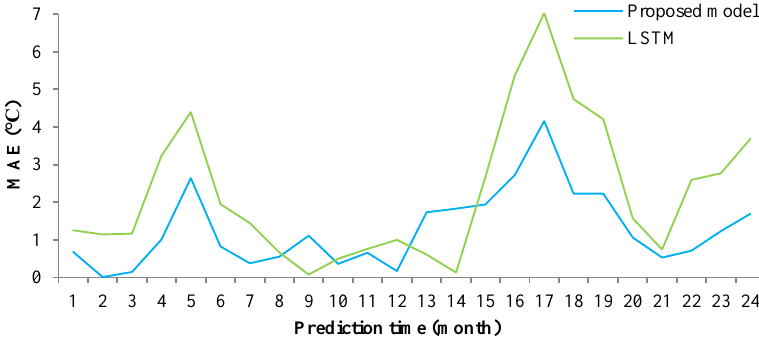
Figure 11. Twenty-four-month prediction accuracy.